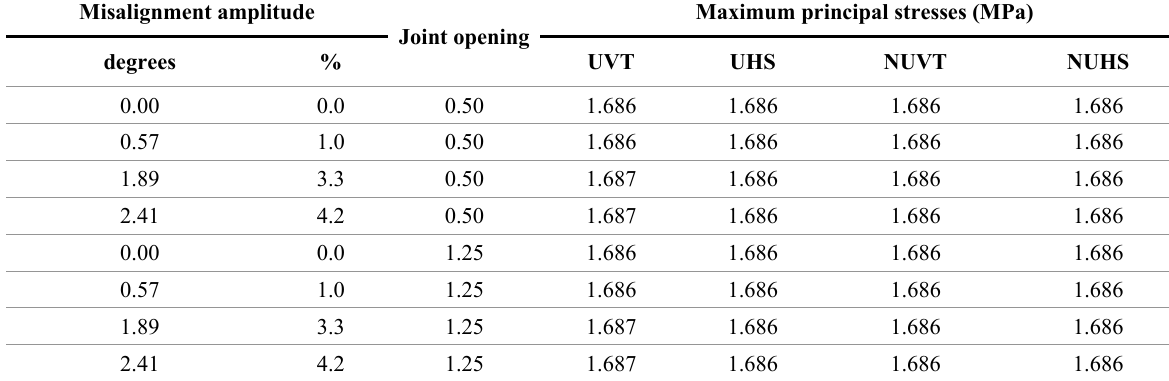
Table 4. Maximum principal stresses caused by joint